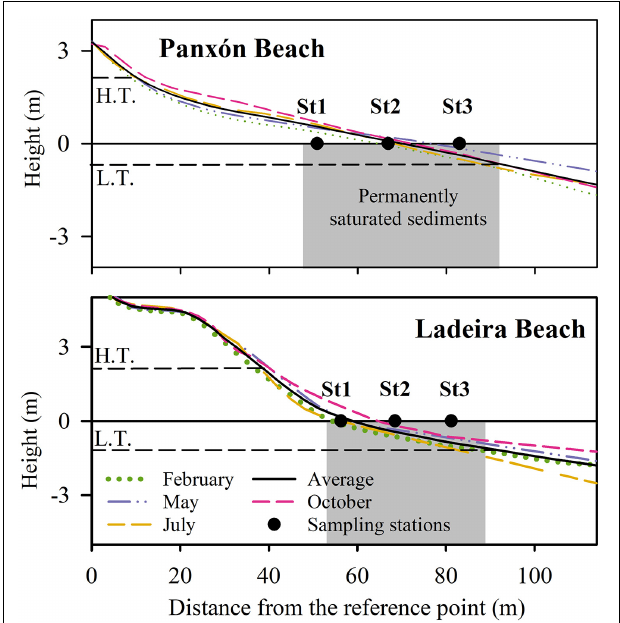
FIGURE 2 | Individual and average beach profiles of Panxón (upper panel) and Ladeira (lower panel). Panxón average beach slope was 3.00% (February: 2.90%, May: 2.44%, July: 3.31%, and October: 3.38%). Ladeira average beach slope was 6.86% (February: 6.71%, May: 7.10%, July: 6.54%, and October: 7.08%). Beach slopes were calculated with the data from the intertidal zone. Black dots represent the averaged location of the three sampling stations. The dark gray area represents the permanently saturated zone. HT, approximate position of high tide; LT, approximate position of low